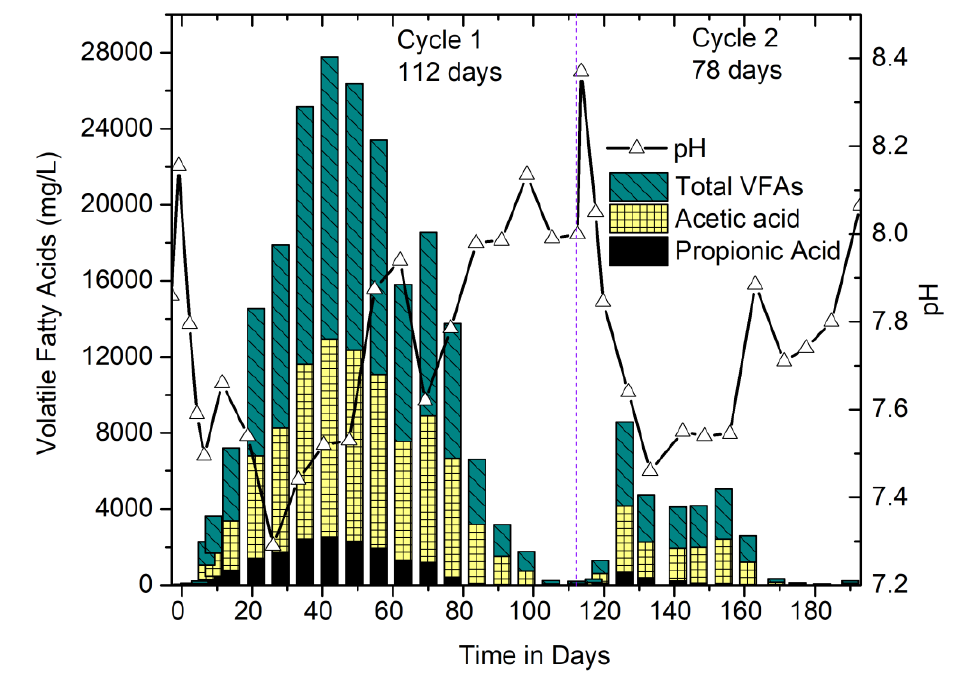
Figure 3. Correlation between volatile fatty acids (VFAs), pH, and methane concentration.